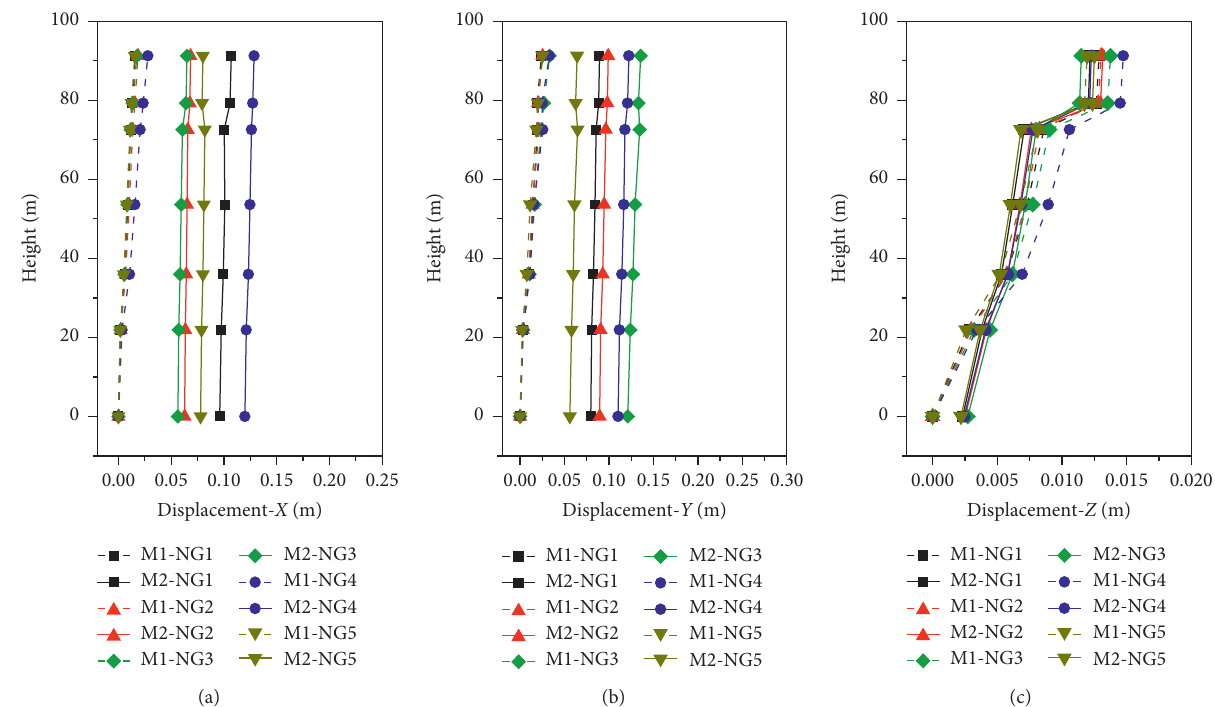
Figure 16: Comparison of peak relative displacement along the height of structure under NG1-NG5: (a) X -direction, (b) Y -direction, and (c) Z